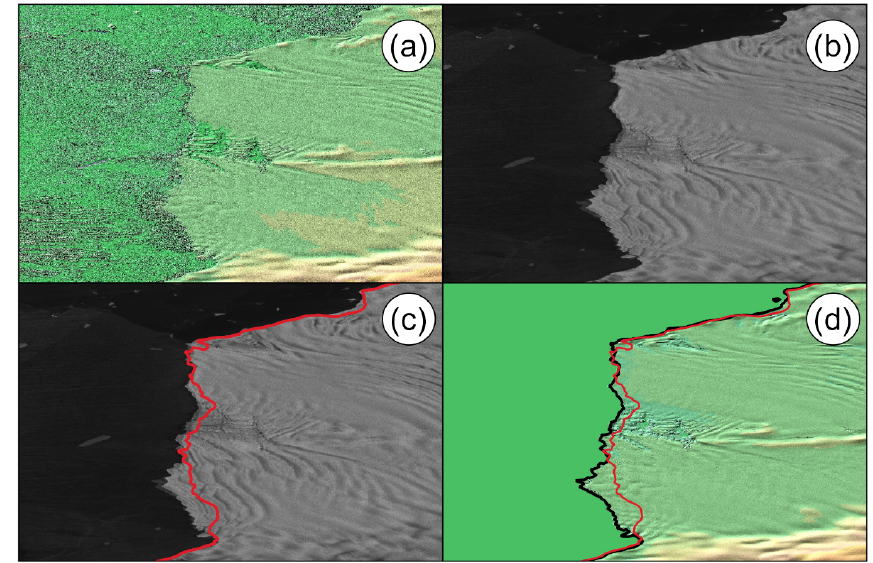
Figure 8. TanDEM-X semi-automatic coastline delineation – example of Mackenzie Bay, Amery Ice Shelf. (a, b) Input: DEM and amplitude of TanDEM-X DEM, (c) SCAR coastline superimposed in red, and (d) TanDEM-X coastline derived from DEM and amplitude in black and SCAR in red, superimposed on tailored and geoid-filled DEM.